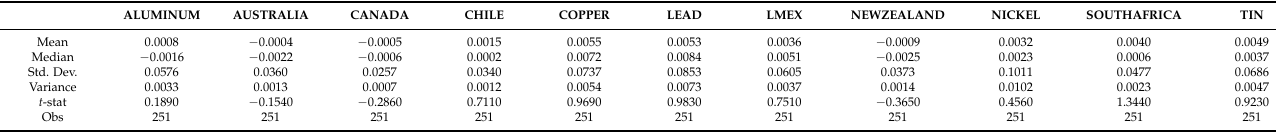
Table A6. Summary statistics of several monthly